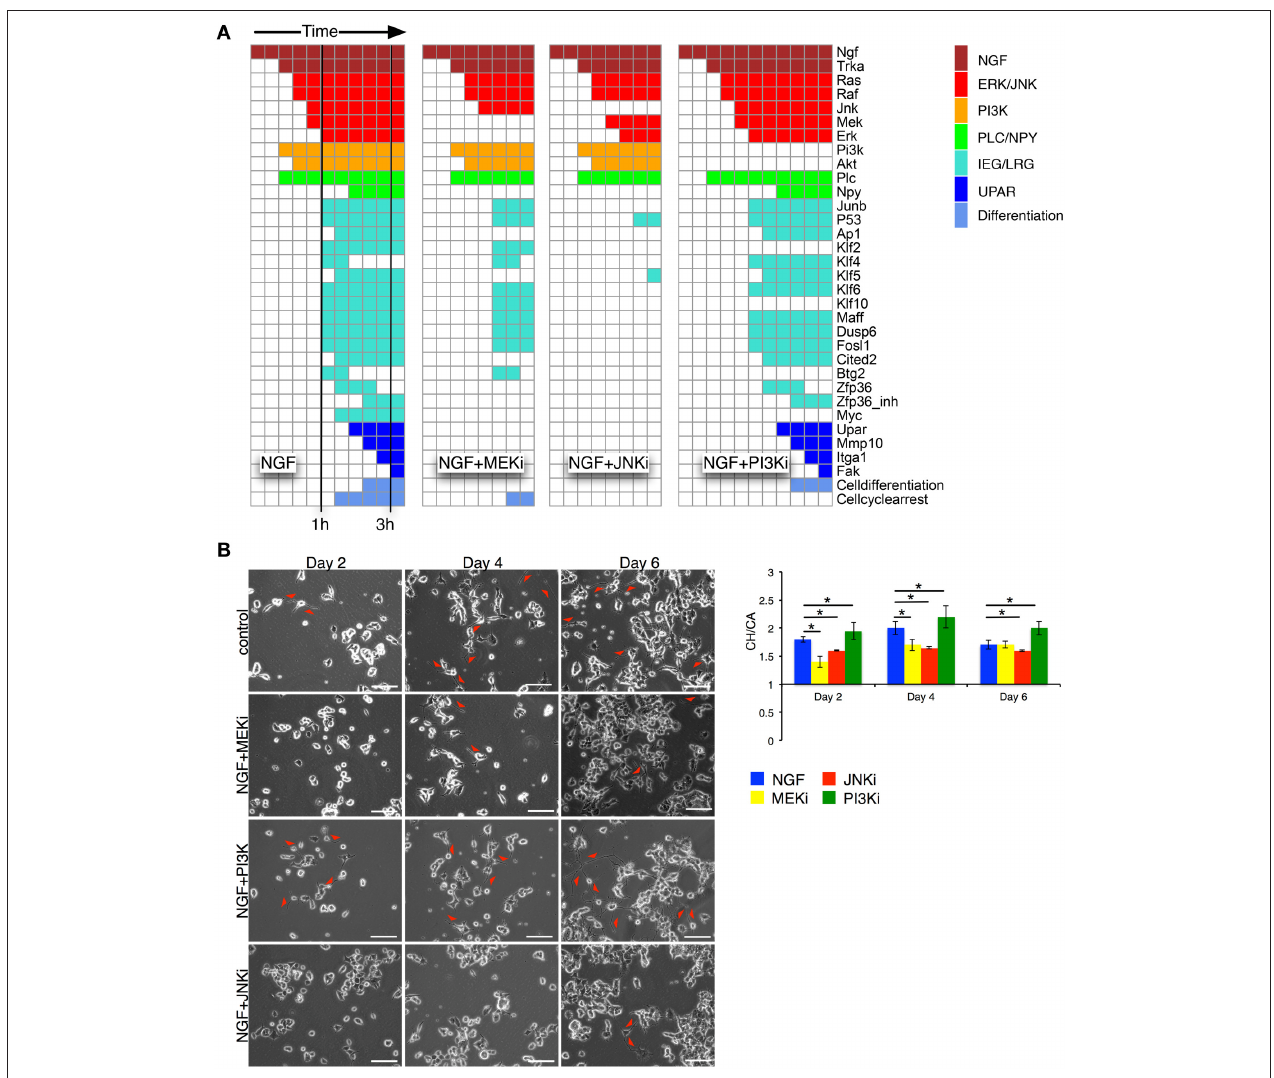
FIGURE 4 | Network simulation of time sequential pathway activation and experimental validation. (A) The heatmaps depict the path to attractor upon NGF stimulation. Columns correspond to synchronous update steps of the Boolean network. Time progresses from left to right until a steady state is reached. Initially all nodes, except NGF, are set to zero. Colored boxes correspond to activated nodes with the color denoting individual pathways/node categories. Cells are predicted to differentiate, if the node “Cell differentiation” is active, as in the case for NGF, or NGF+PI3Ki treatment. (B) Left: phase contrast images for days 2, 4, and 6 are shown for the 4 different conditions: NGF (control), NGF + MEKi, NGF + PI3Ki and NGF + JNKi. Red arrows depict sites of neurite outgrowth in differentiating PC12 cells. Bar: 100 µ m. Right: statistical analysis of PC12 cell differentiation from phase contrast imaging for the different conditions are shown as convex hull (CH) to cell area (CA) ratio. Bars show Mean ± SEM, n = 2, ( * t -test p -value < 0.05